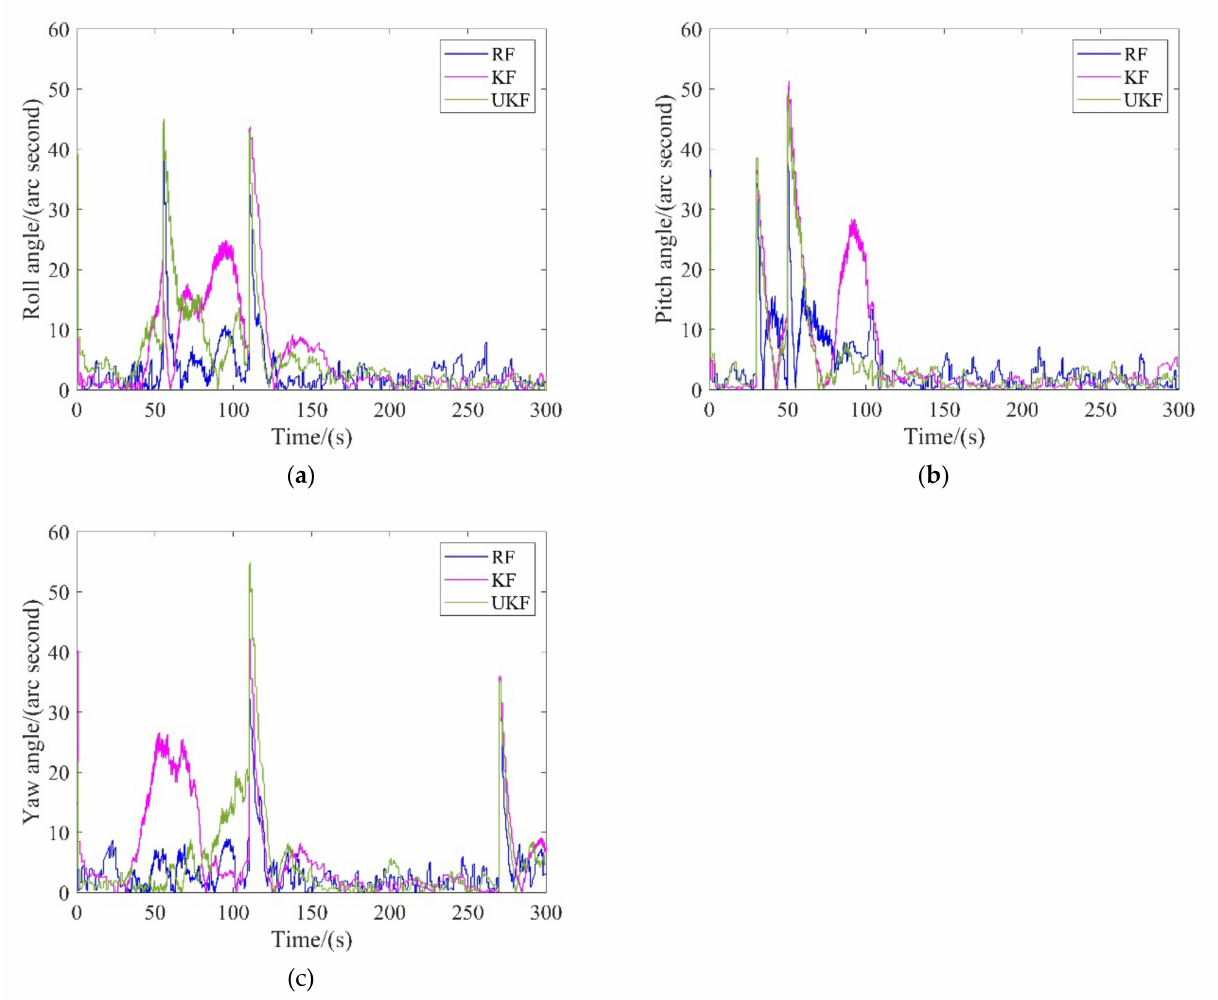
Figure 6. ( a ) Roll-angle error contrast curves; ( b ) Pitch-angle error contrast curves; ( c ) Yaw-angle error contrast curves. Angle-error contrast curves under the launch inertial coordinate system.